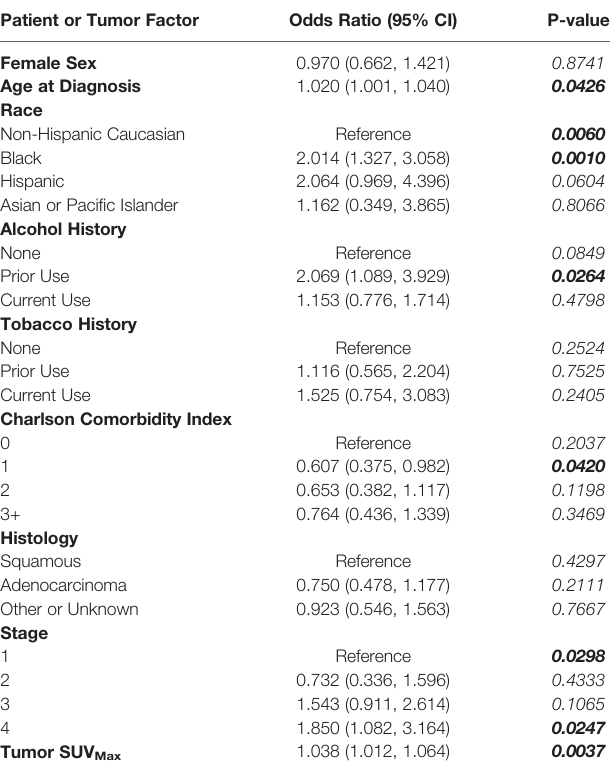
TABLE 2 | Multivariate Logistic Regression Evaluating Relationship of Tumor SUV Max with Patient and Tumor Characteristics as Covariates with Incidence of Signi fi cant Pretreatment Cancer-Associated Weight Loss (WL). Patient or Tumor Factor